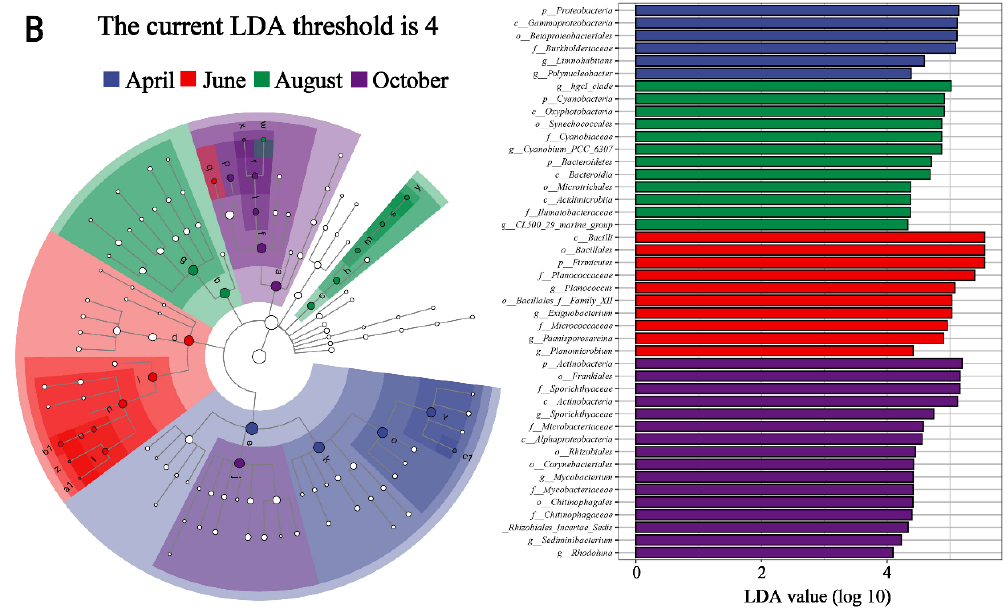
Figure 4. Composition heatmap ( A ) and LefSe analysis ( B ) of microbial communities.